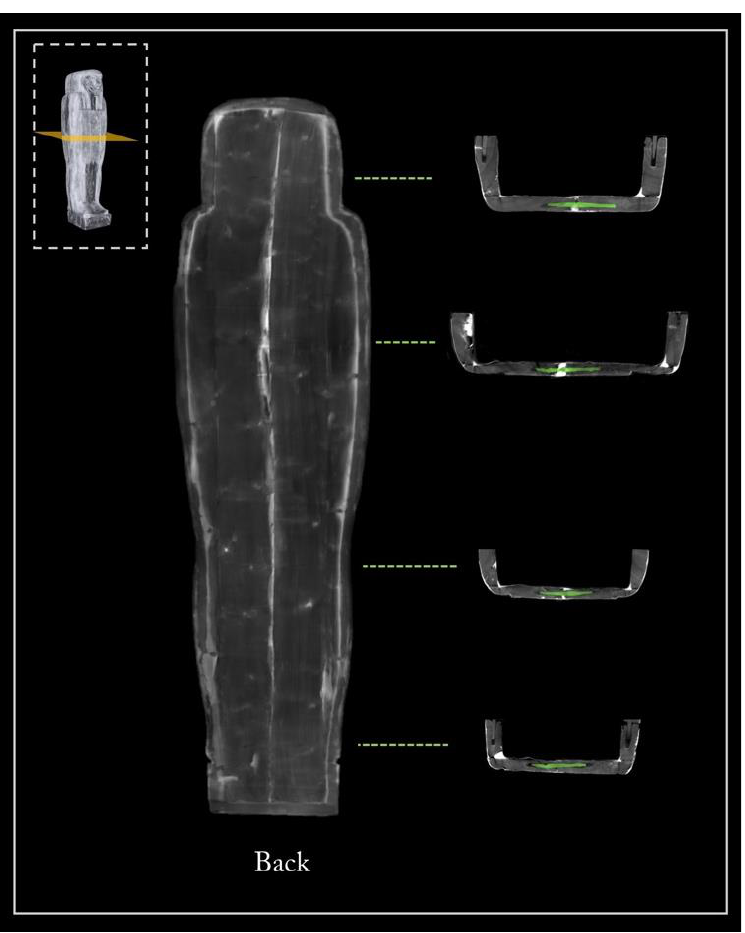
Figure 6. 3D rendering of the underside of the floor board: in green, the four dowels joining the two planks.